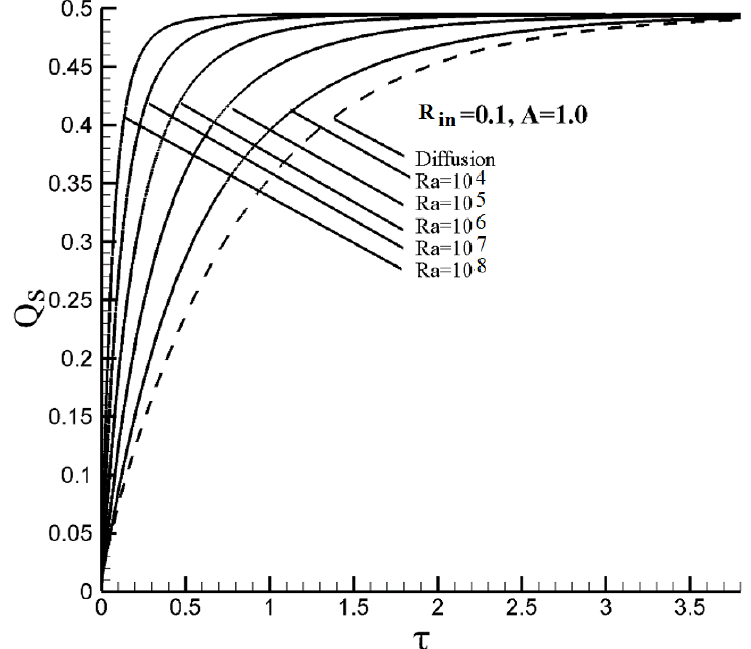
Figure 8. The thermal energy accumulated in the tank as a function of time for different Ra and for R in = 0.1.